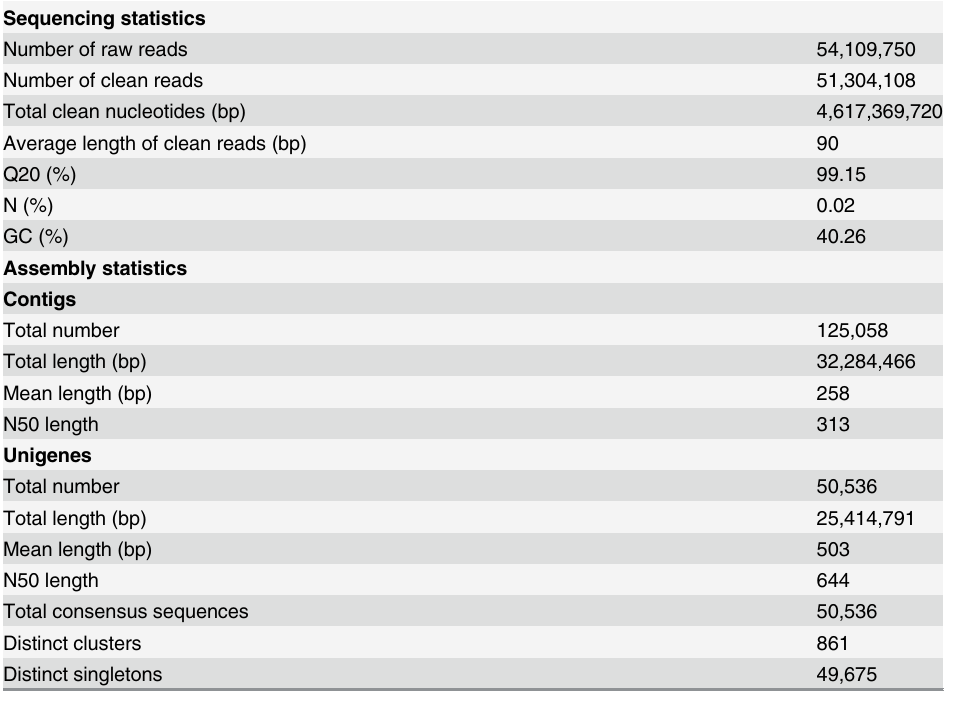
Table 1. Summary of the C . capillata tentacle